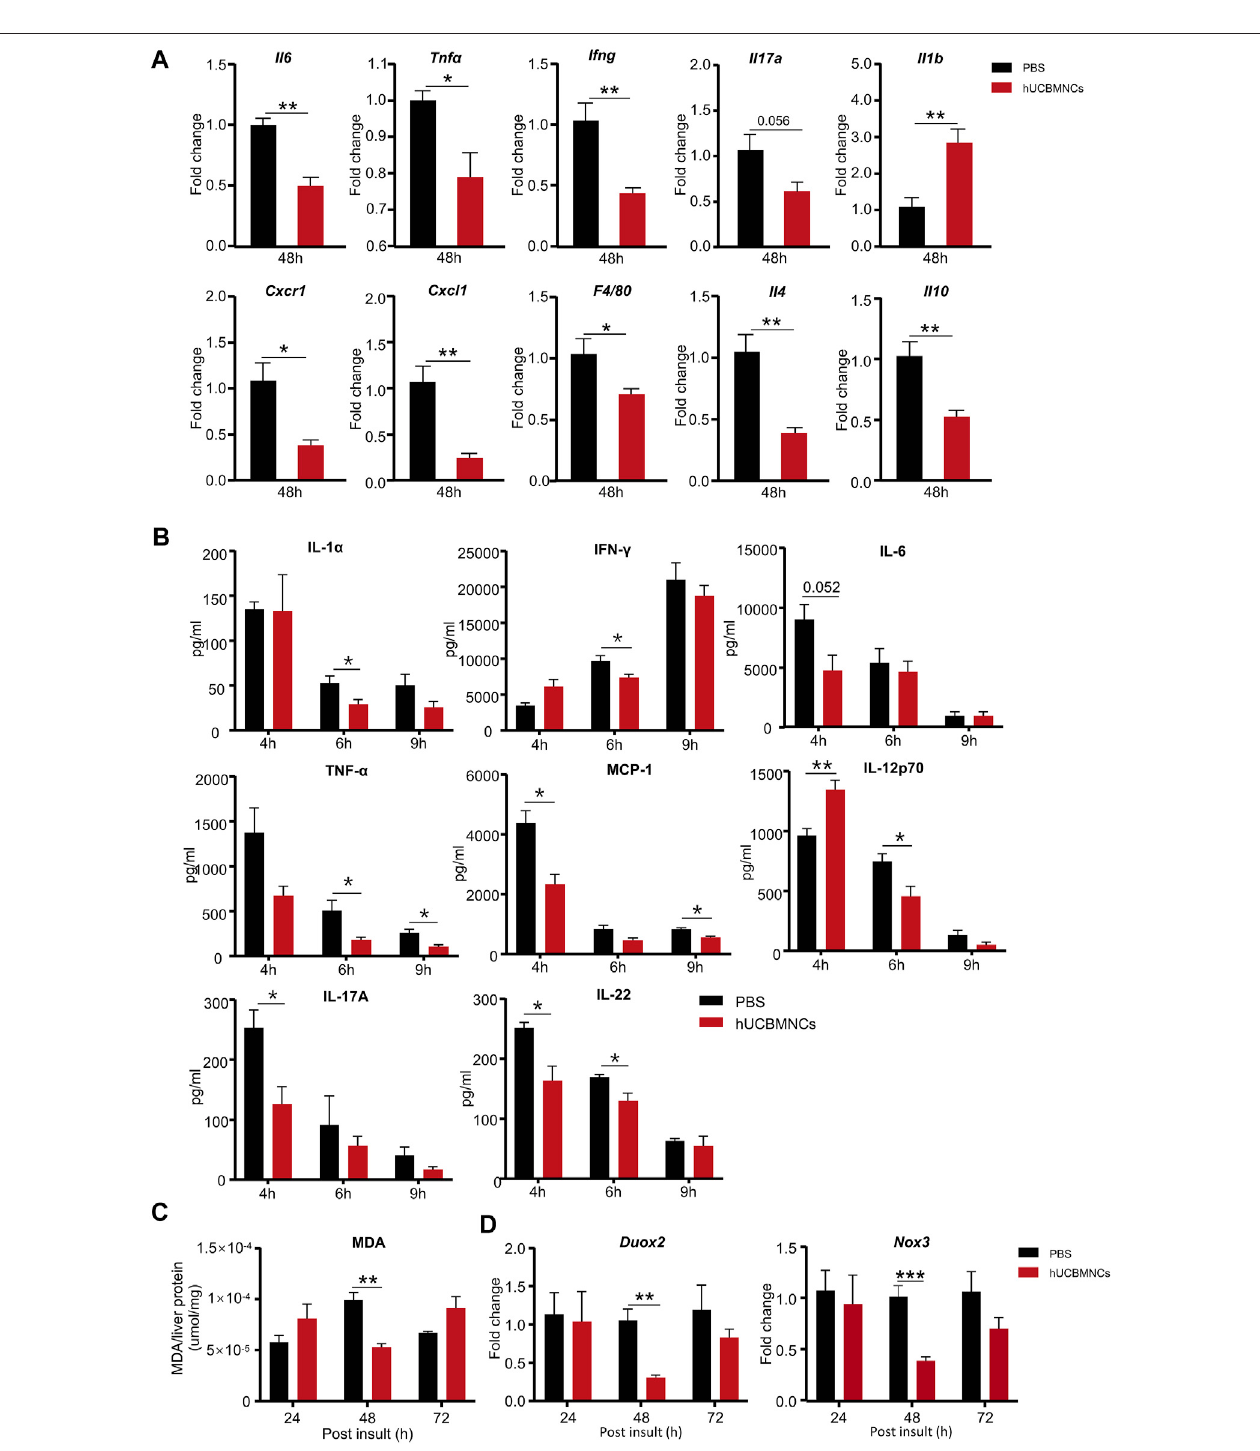
FIGURE 3 | hUCBMNCs treatment suppressed in fl ammation and oxidative stress in mice liver in CCl 4 -induced acute liver injury and ConA-induced liver injury. (A) mRNA levels of liver representative in fl ammatory markers in hUCBMNCs and control groups at 48h post CCl 4 injection ( n = 5/time point, experiments were repeated for 3 times). (B) Protein levels of serum in fl ammatory cytokines in ConA-induced liver injury mouse model at 4, 6, and 9h ( n = 5/time point). (C) Malondialdehyde (MDA) expression in liver tissue at 24, 48,and 72h post CCl 4 insult ( n = 5/time point, experiments were repeated for 3 times). (D) mRNA expression levels of Duox2 and Nox3 in liver at 24, 48, and 72h post CCl 4 injection ( n = 5/time point, experiments were repeated for 3 times). The bars represent mean ± SEM.